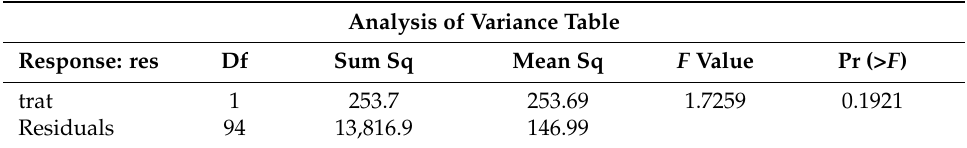
Table A19. R output of ANOVA among the residues generated from the estimation of CFM using species equation and age specific equation for C